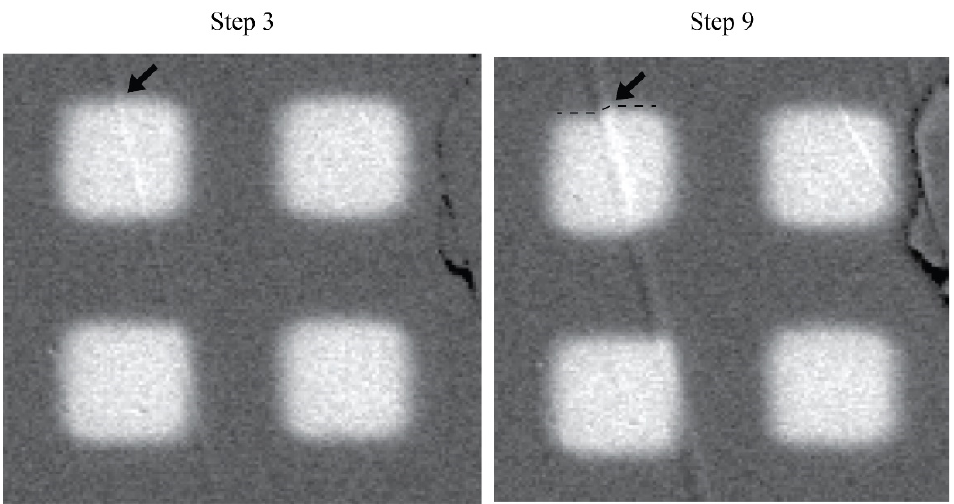
Figure 9. SEM image of the first twin lamella appearing in crystal 9 and its thickening with the progressive increase in the deformation. A square in the image is 12 µm wide.